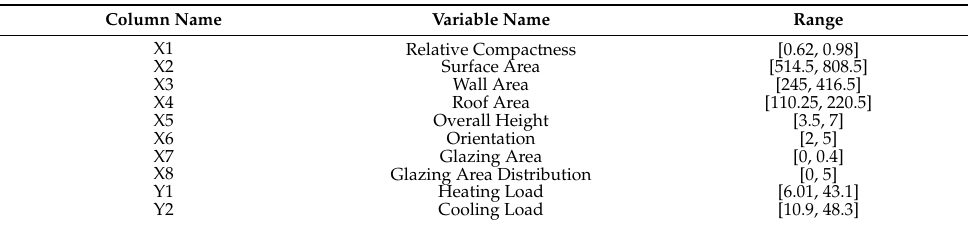
Table 8. Energy Efficiency Dataset Attribute Information Summary.